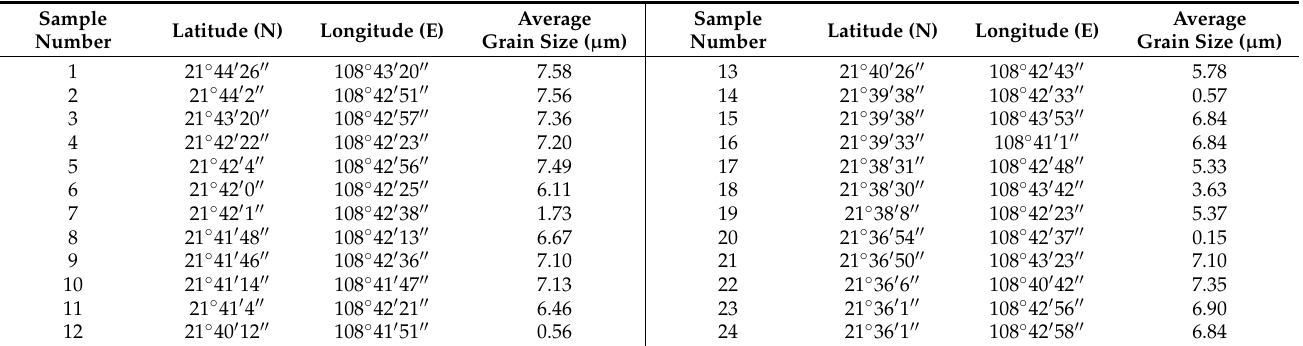
Table 1. Information on sampling location and average grain size of surface sediments in the Lu’erhuan River Sea area of Qinzhou Bay, Guangxi